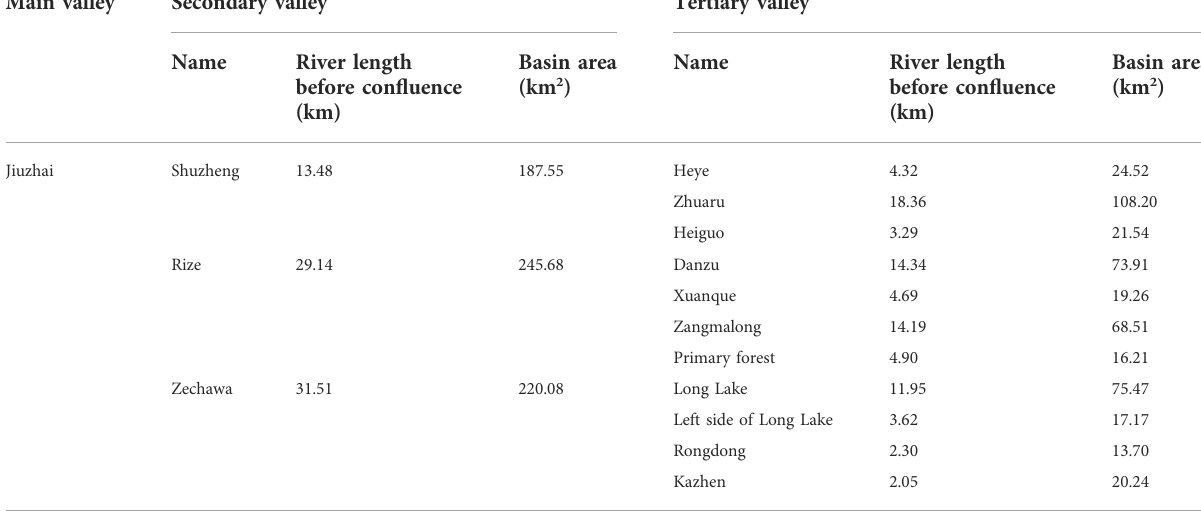
TABLE 1 Characteristics of the main valleys and river systems in the Jiuzhai National Nature Reserve. Main